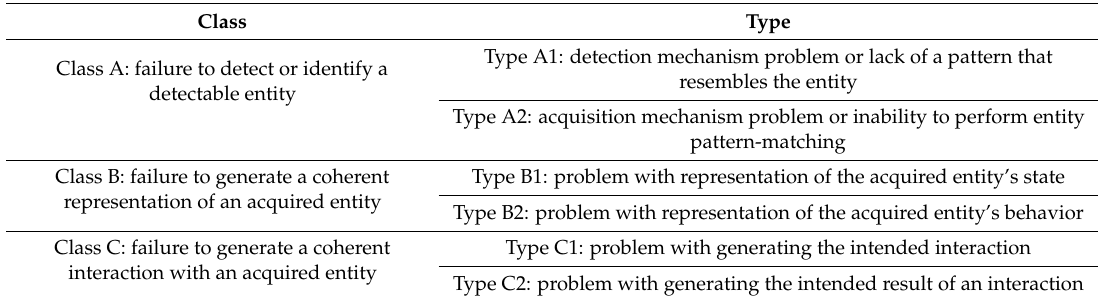
Table 2. Classes and Types of